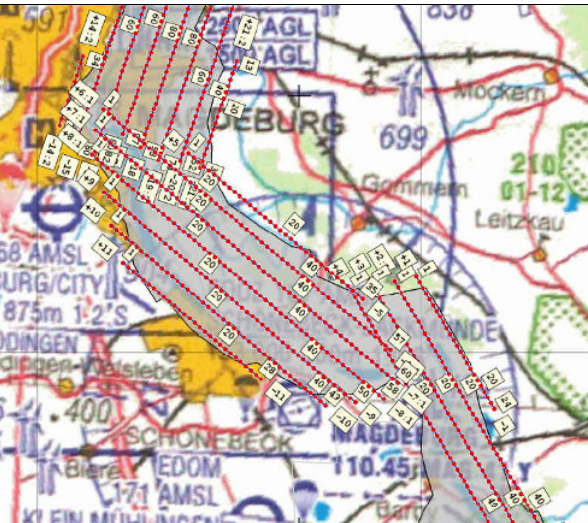
Fig 4: Flight planning near Magdeburg (excerpt)